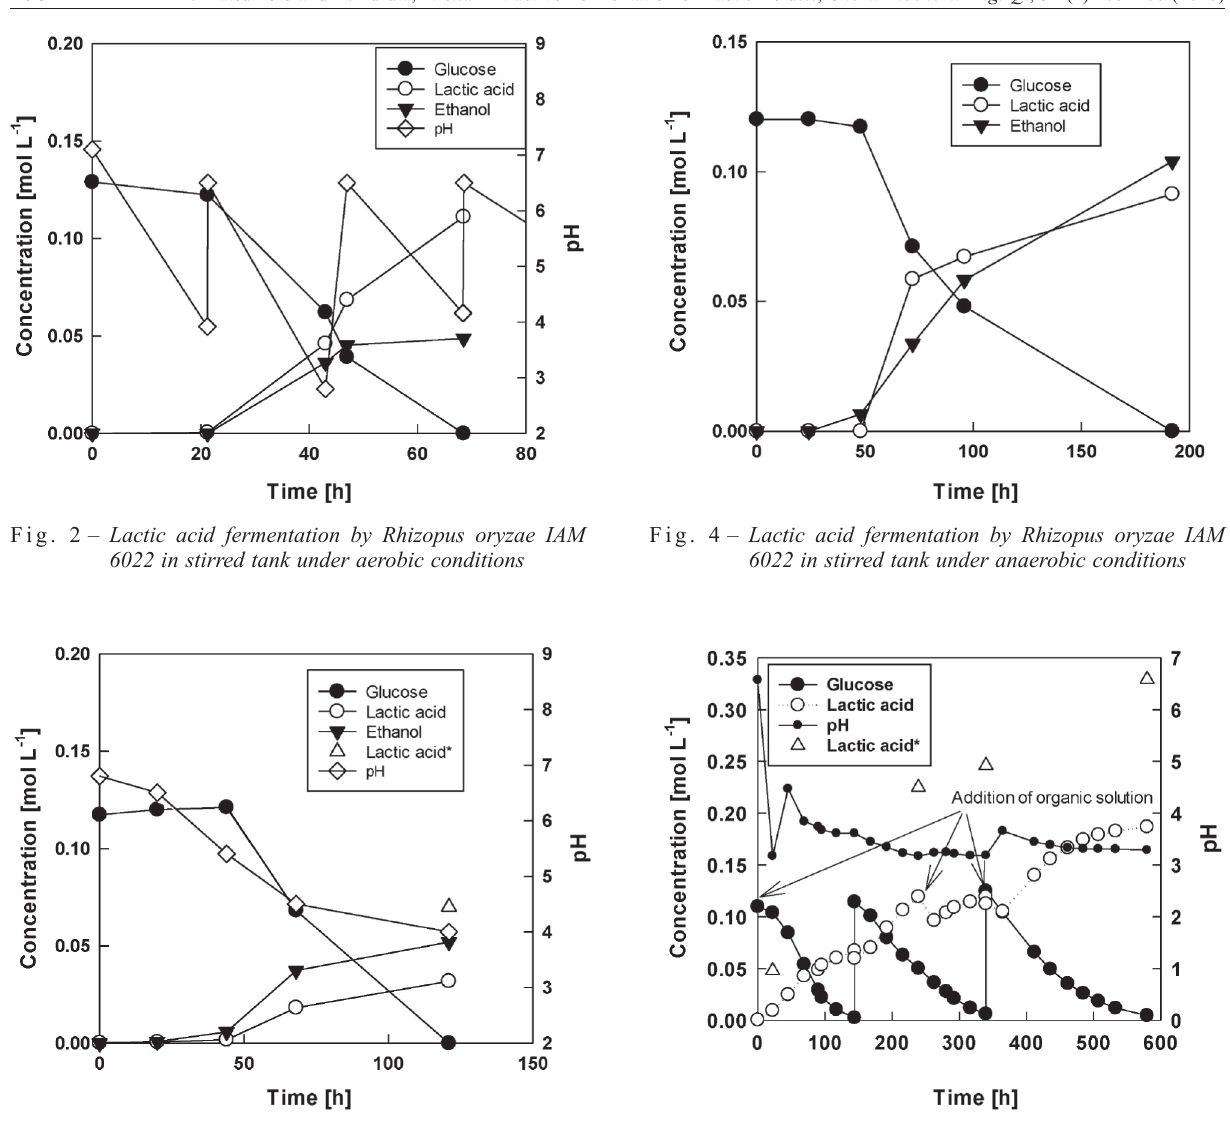
Fig. 5 – Extractive fermentation of lactic acid by Rhizopus oryzae IAM 6022 in air-lift reactor (*lactic acid produced considering lactic acid extracted in organ- ic